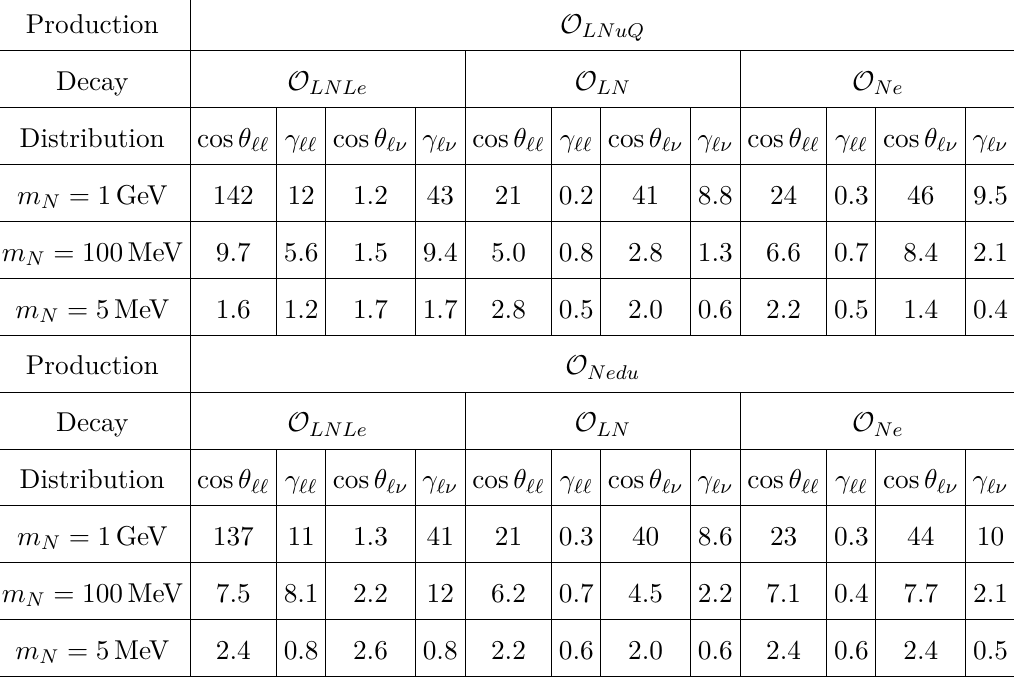
Table 6 . Distinguishing between Dirac and Majorana N . χ 2 production and decay operators in